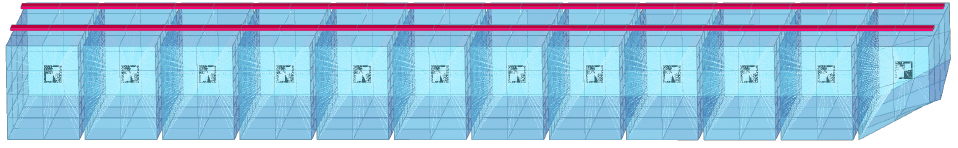
Figure 2. Finite element model of the barge (red— beam elements, blue—plate elements, black—mass elements, white—rigid connections).